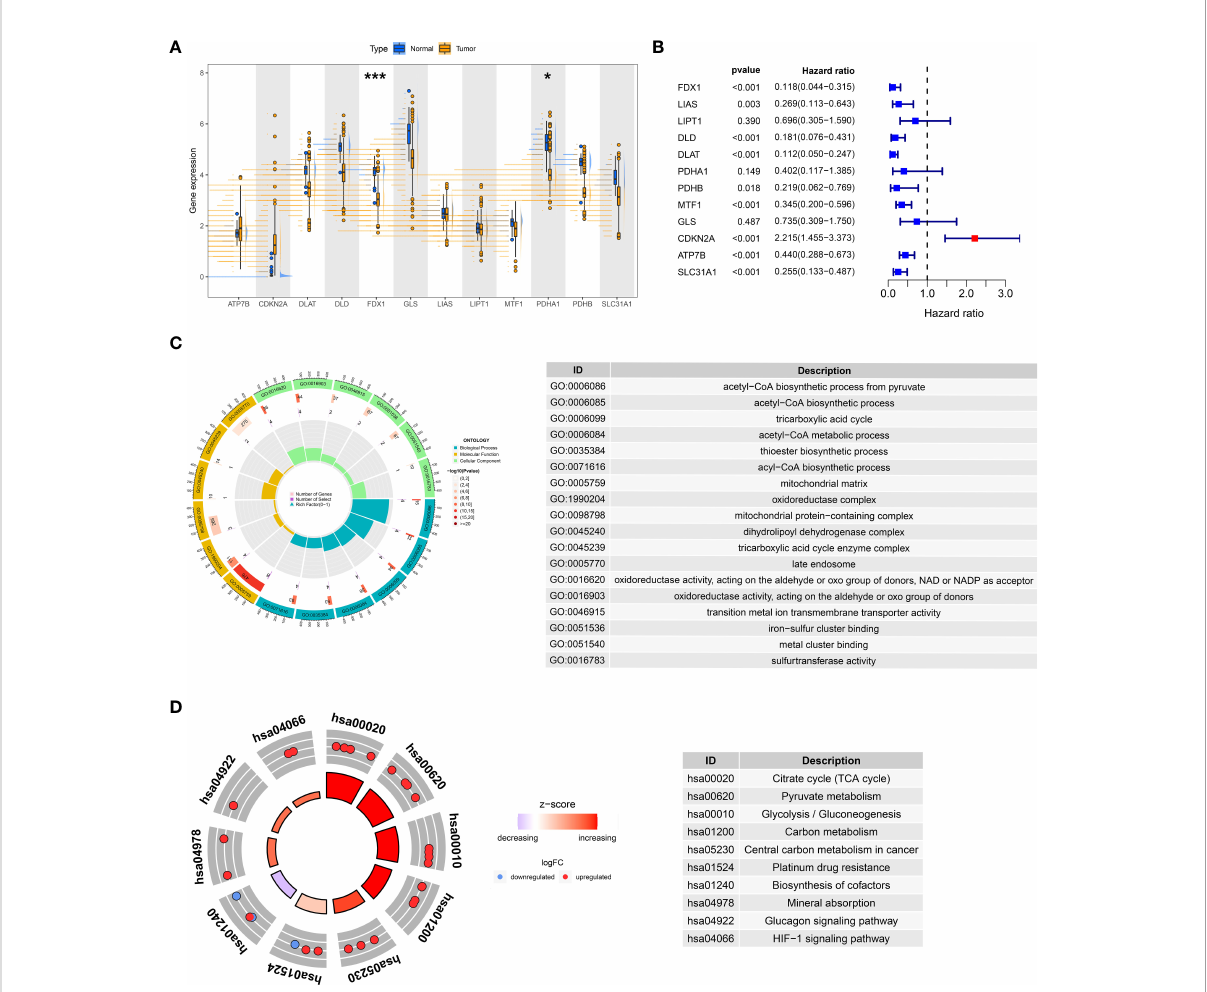
FIGURE 1 Expression and prognosis of cuproptosis genes in the TCGA-KIRC cohort. (A) Variable expression distribution of cuproptosis genes in TCGA- KIRC. (B) Cox regression analysis of TCGA-KIRC with cuproptosis genes. GO (C) and KEGG (D) analysis of cuproptosis genes. * P < 0.05, *** P <